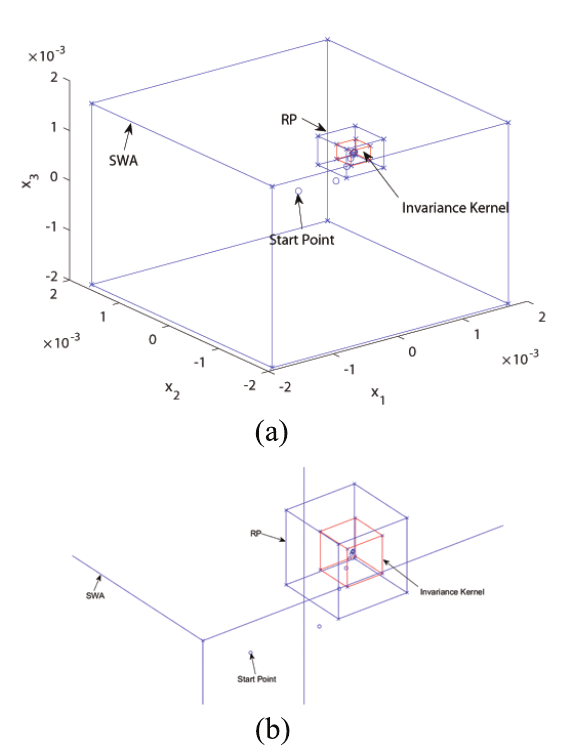
Figure 9. ( a ) A normal pH system simulation ( b ) Zoom.